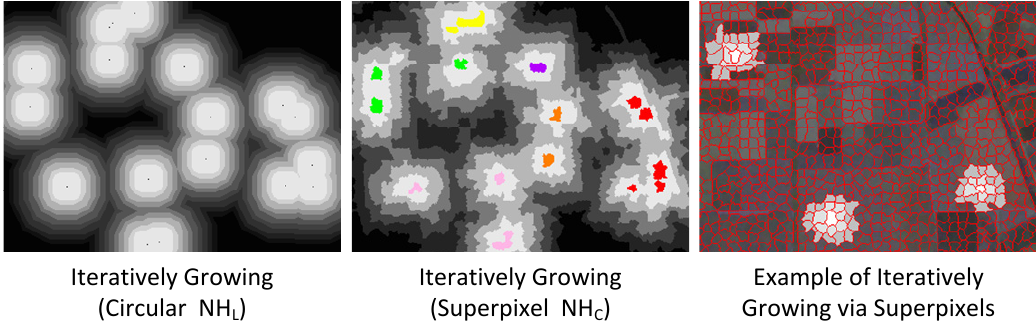
Figure 6. Examples of the growing process for the circular- and superpixel-based search over the selected image area. The colors for NH shades of gray indicate the growth of the SSL iterations with black areas are not considered for selection at